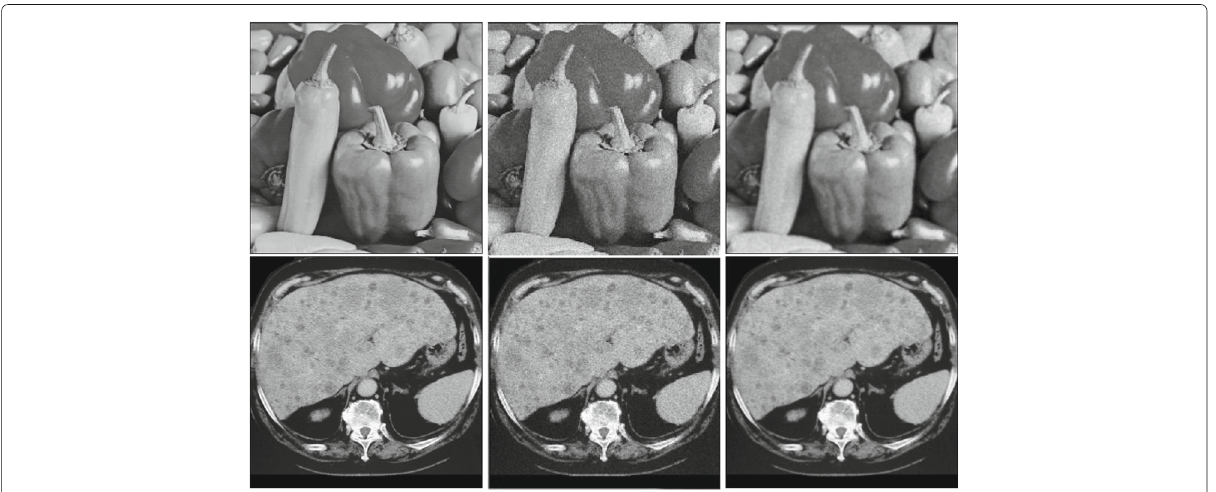
Fig. 4 Leftcolumn , original images; middlecolumn, noisy images corrupted by poissonian noise; rightcolumn restored images with λ = 60